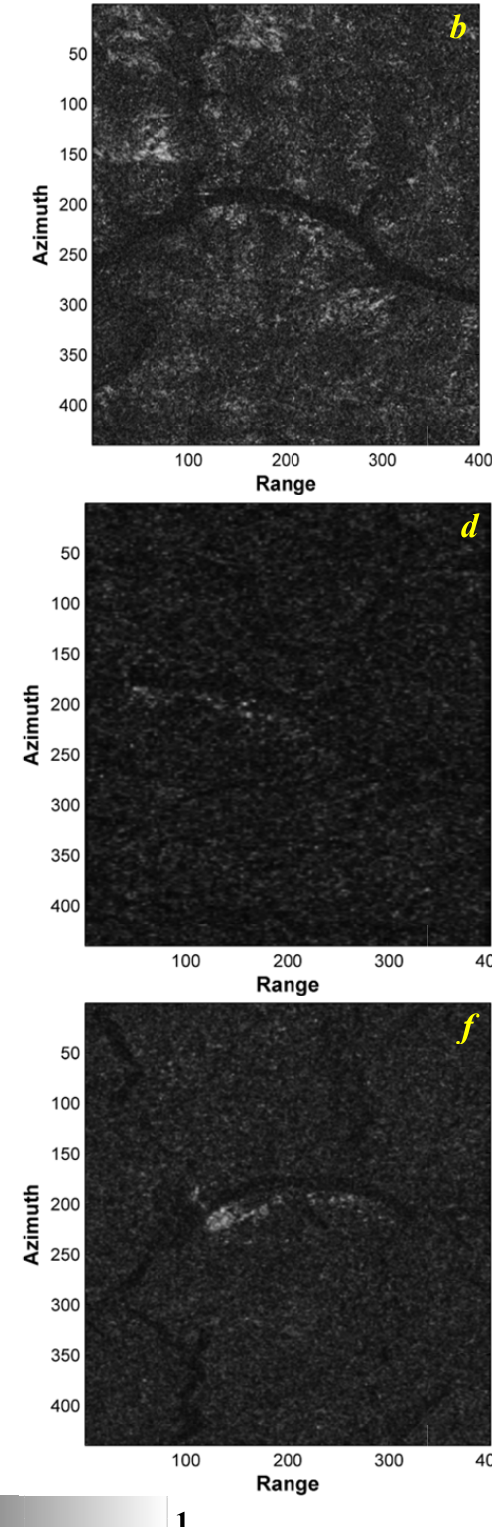
dth the int literferogram data pairs isted in Tab